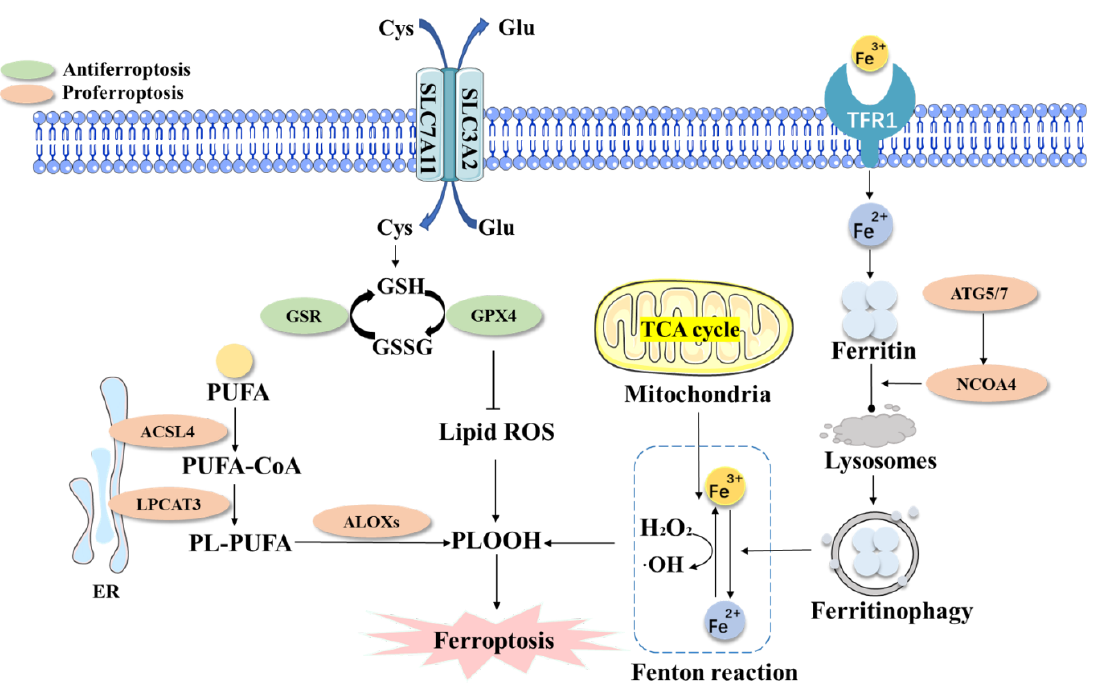
Figure 1. The core mechanism of ferroptosis. Ferroptosis is mainly caused by iron-dependent lipid peroxidation (PLOOH). The xc - system imports cystine into cells with the 1:1 counter-transport of glutamate. GPX4 converts GSH to GSSG and reduces PLOOH, thereby blocking the lipid peroxidation chain reaction and inhibiting ferroptosis. Several proteins (including TFR1, NCOA4, ATG5, and ATG7) mediate ferritinophagy and promote iron accumulation in ferroptosis through the regulation of iron metabolism. Fe 2+ can greatly induce PLOOH through the Fenton reaction, which then induces ferroptosis. Increasing PUFA synthesis can increase the sensitivity to ferroptosis, which is mainly regulated by ACSL4 and LPCAT3. Abbreviations: SLC7A11,zd solute carrier family 7 member 11; SLC3A2, solute carrier family 3 member 2; GSH, glutathione; GSSG, glutathione disulfide; GPX4, glutathione peroxidase 4; PLOOH, phospholipid hydroperoxide; ROS, reactive oxygen species;